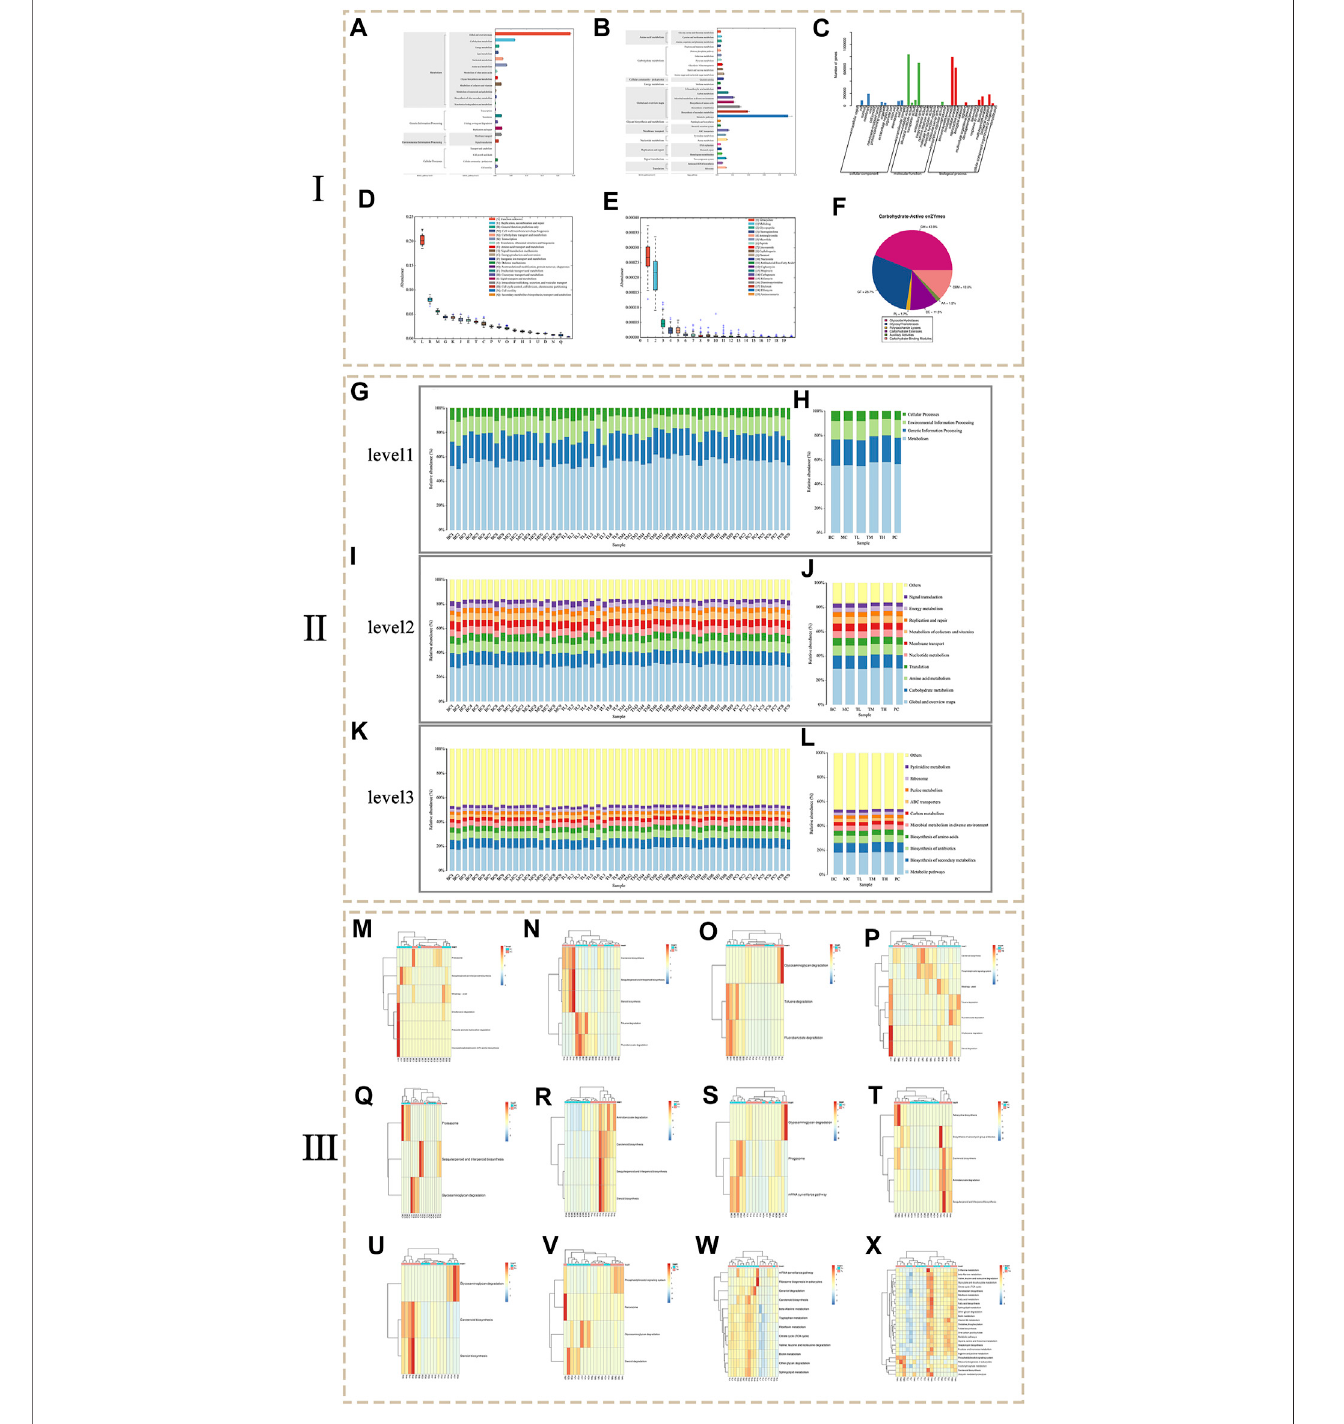
FIGURE 6 | The results of metagenomics sequencing. ( Ⅰ : Functional annotation analysis. Ⅱ : Histogram of KEGG pathway composition and abundance. Ⅲ : Heat map of metagenomeSeq differential pathway abundance).